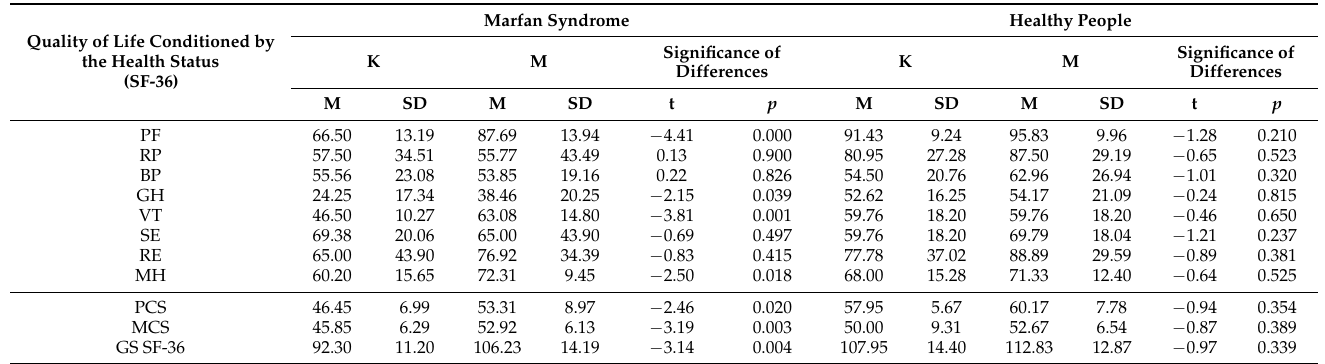
Table 5. Comparison of mean results obtained in different areas of the quality of life in both studied groups with regards to gender.